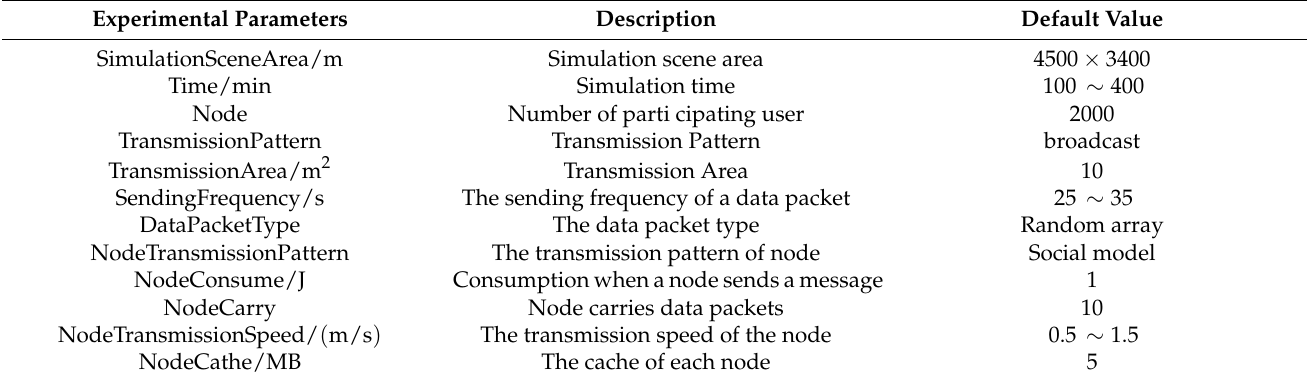
Table 1. Experimental parameters configuration.